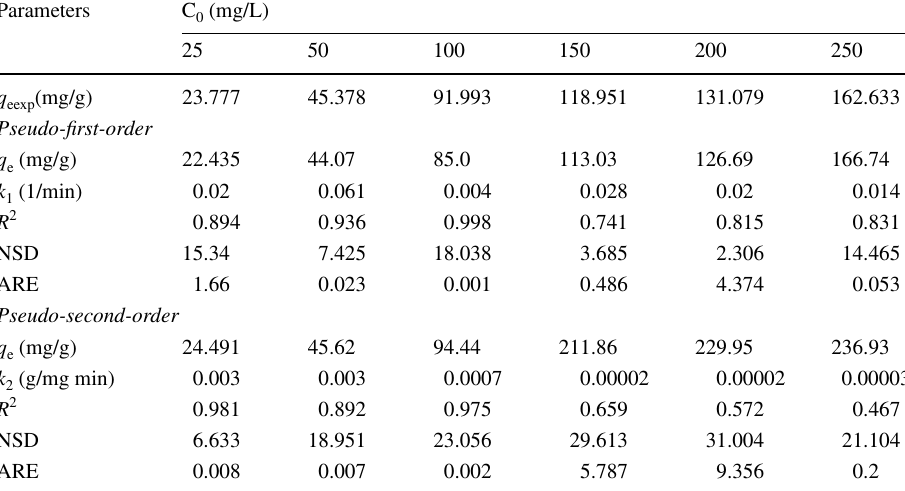
Table 4 Kinetic parameters for adsorption of MB onto BNH-CM at different initial concentrations